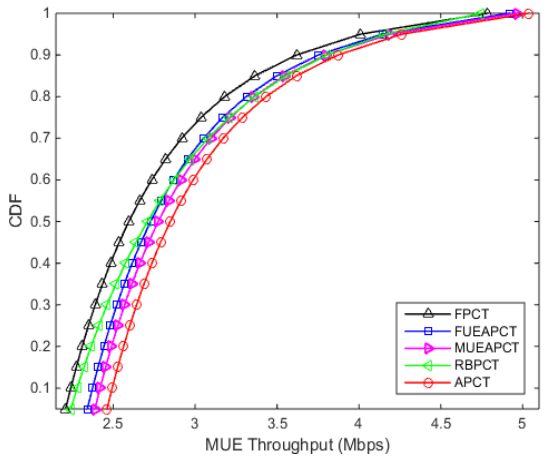
Figure 3. Downlink Throughput CDF of the Macrocell User.